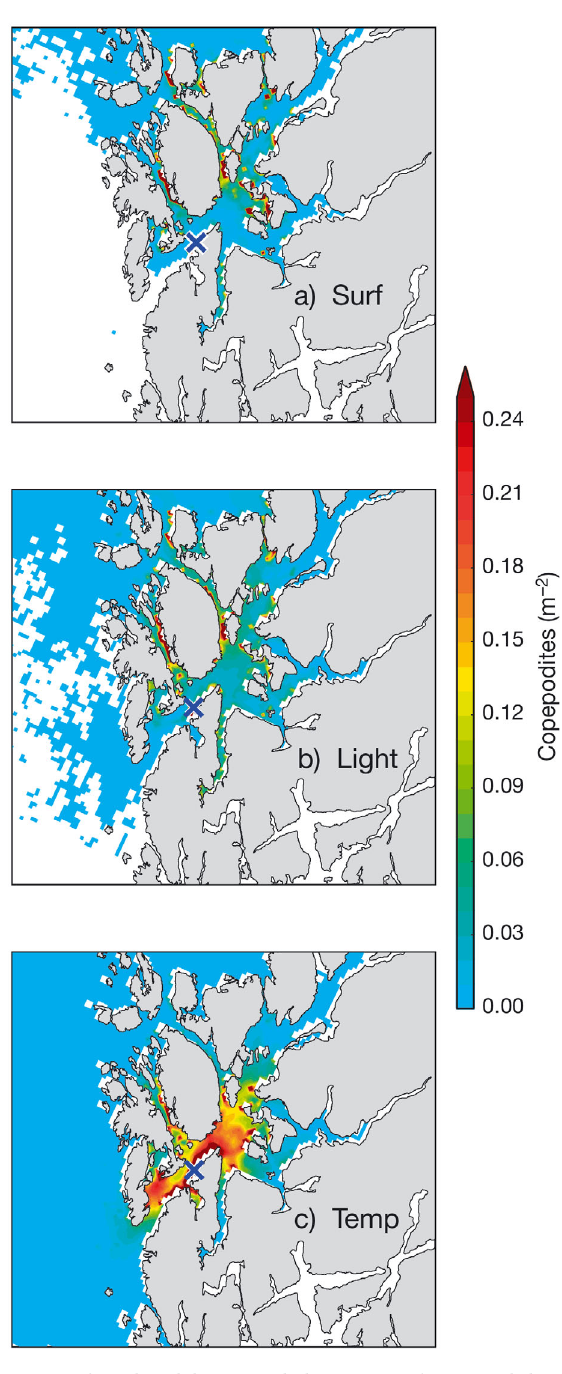
Fig. 6. Simulated horizontal dispersion of Lepeophtheirus salmonis in the Hardangerfjord during 1−31 March 2009 based on current fields from the model NorKyst800. Plots show vertical and time-integrated distribution of copepodite particles with different behaviours: (a) fixed at the surface (Surf), (b) vertical migration controlled by light and salinity (Light), and (c) temperature-controlled vertical migration (Temp). Blue crosses indicate release locations of particles. Particles were counted in grid cells of 800 m × 800 m, and divided by the cell